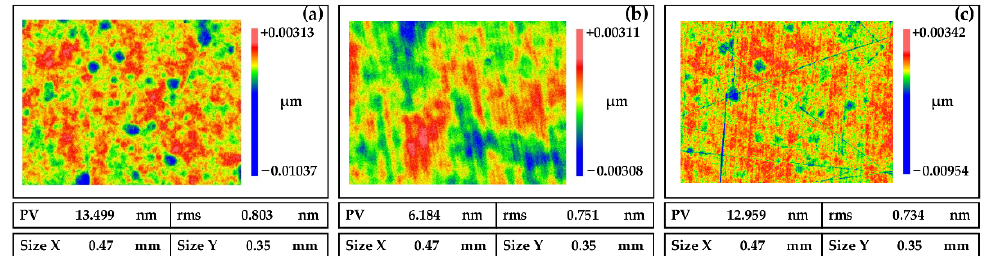
Figure 7. Polished surfaces of NiP coating induced by slurries with pH values at ( a ) 3.5, ( b ) 6.5, and ( c ) 9.5.